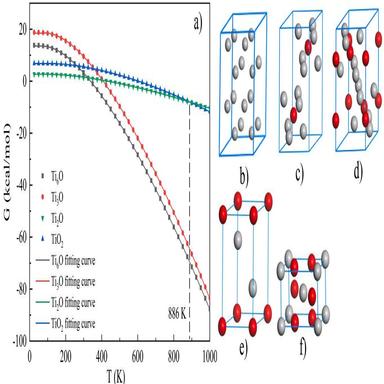
First-principles calculation of the Gibbs free energy of Ti-O compounds: (a) Gibbs free energy data of Ti-O compounds with fitting curves as a function of temperature, (b–f) primitive unit cell structures of Ti-O compounds.